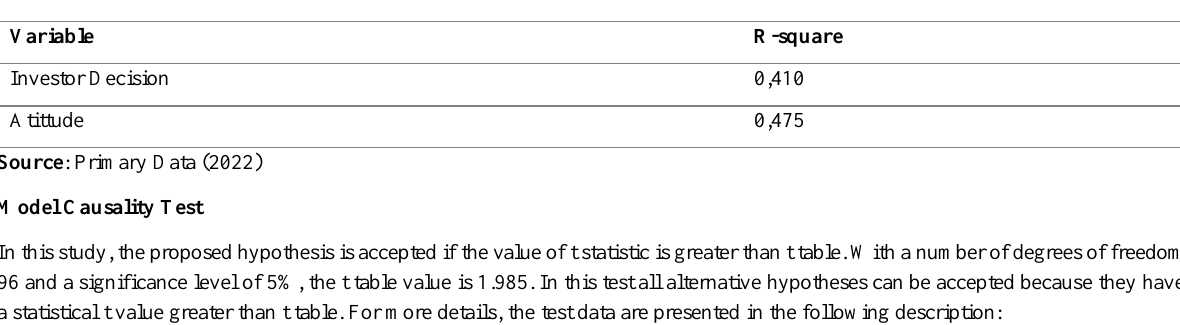
Table 3: Determinant